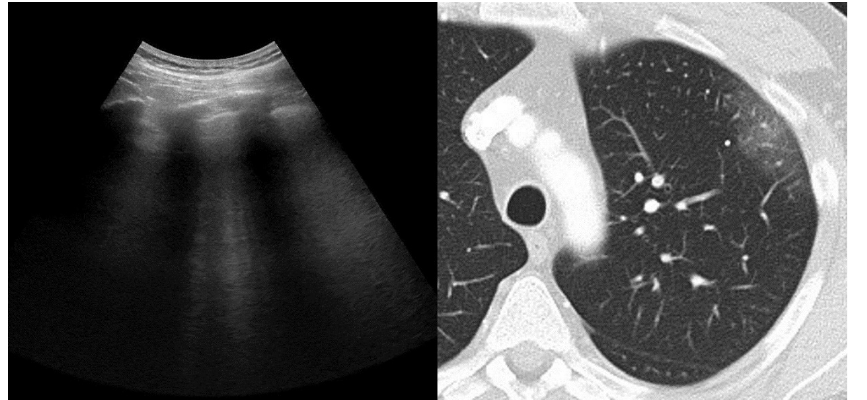
Figure 1. Left panel : LUS demonstrating thickening of the pleural line and intercostal predominantly well-spaced B-lines or B1 pattern. Right panel : CT scan demonstrating bilateral pure GGO.